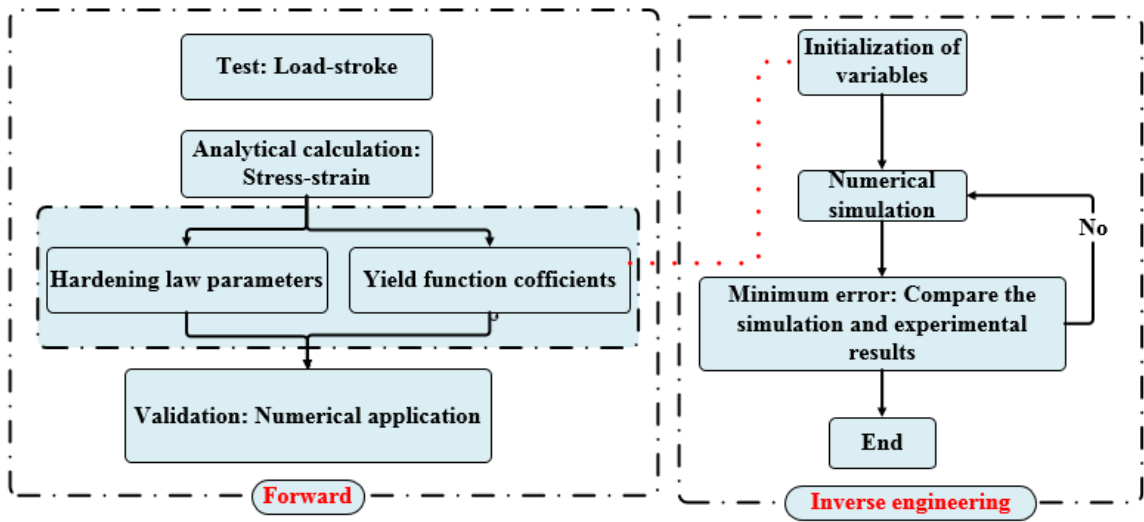
Figure 9. The optimization process of the inverse engineering. The P_Drucker yield function has better prediction accuracy than the von Mises yield function. Hence, the parameters of the combined Swift-Voce model and the P_Drucker yield